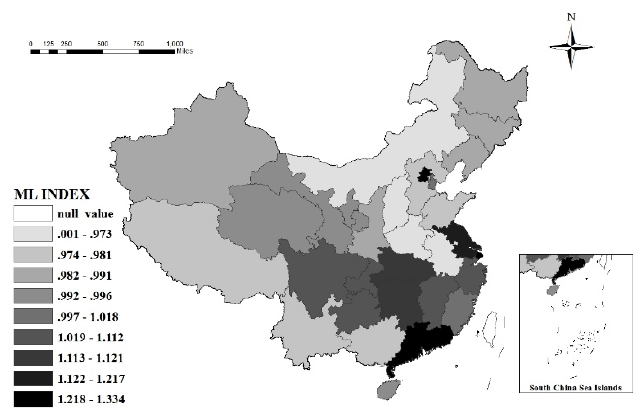
Figure 8. The spatial distribution of the ML index in 31 provinces in China during 2006 to 2018. Note: The geographical base map is from the Ministry of Natural Resources of the P.R.